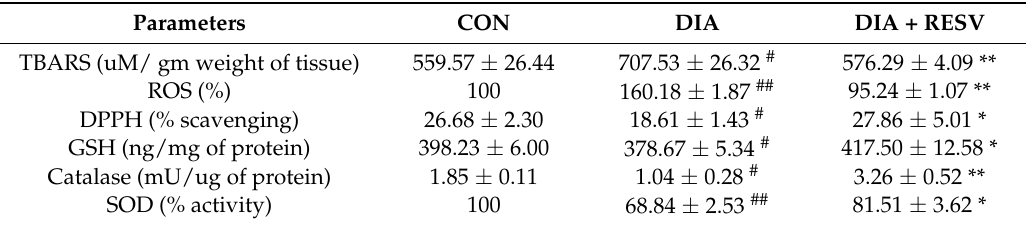
Table 2. Cardiac antioxidant and oxidative stress markers in diabetic rats and effect of resveratrol administration.